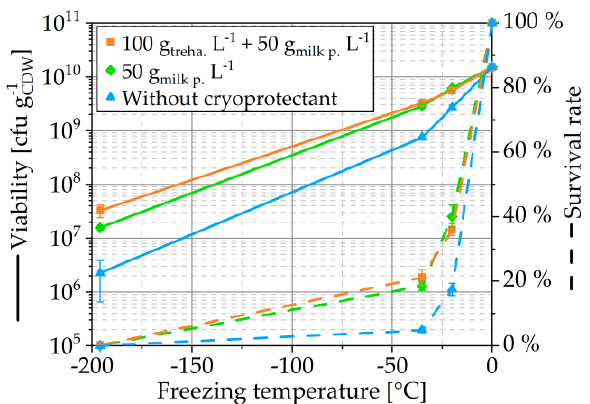
Figure 2. Dependency of viability and survival rate on freezing temperature. Cell concentration was CDW 150 g L −1 . Symbols represent means and error bars standard deviation; n = 3.